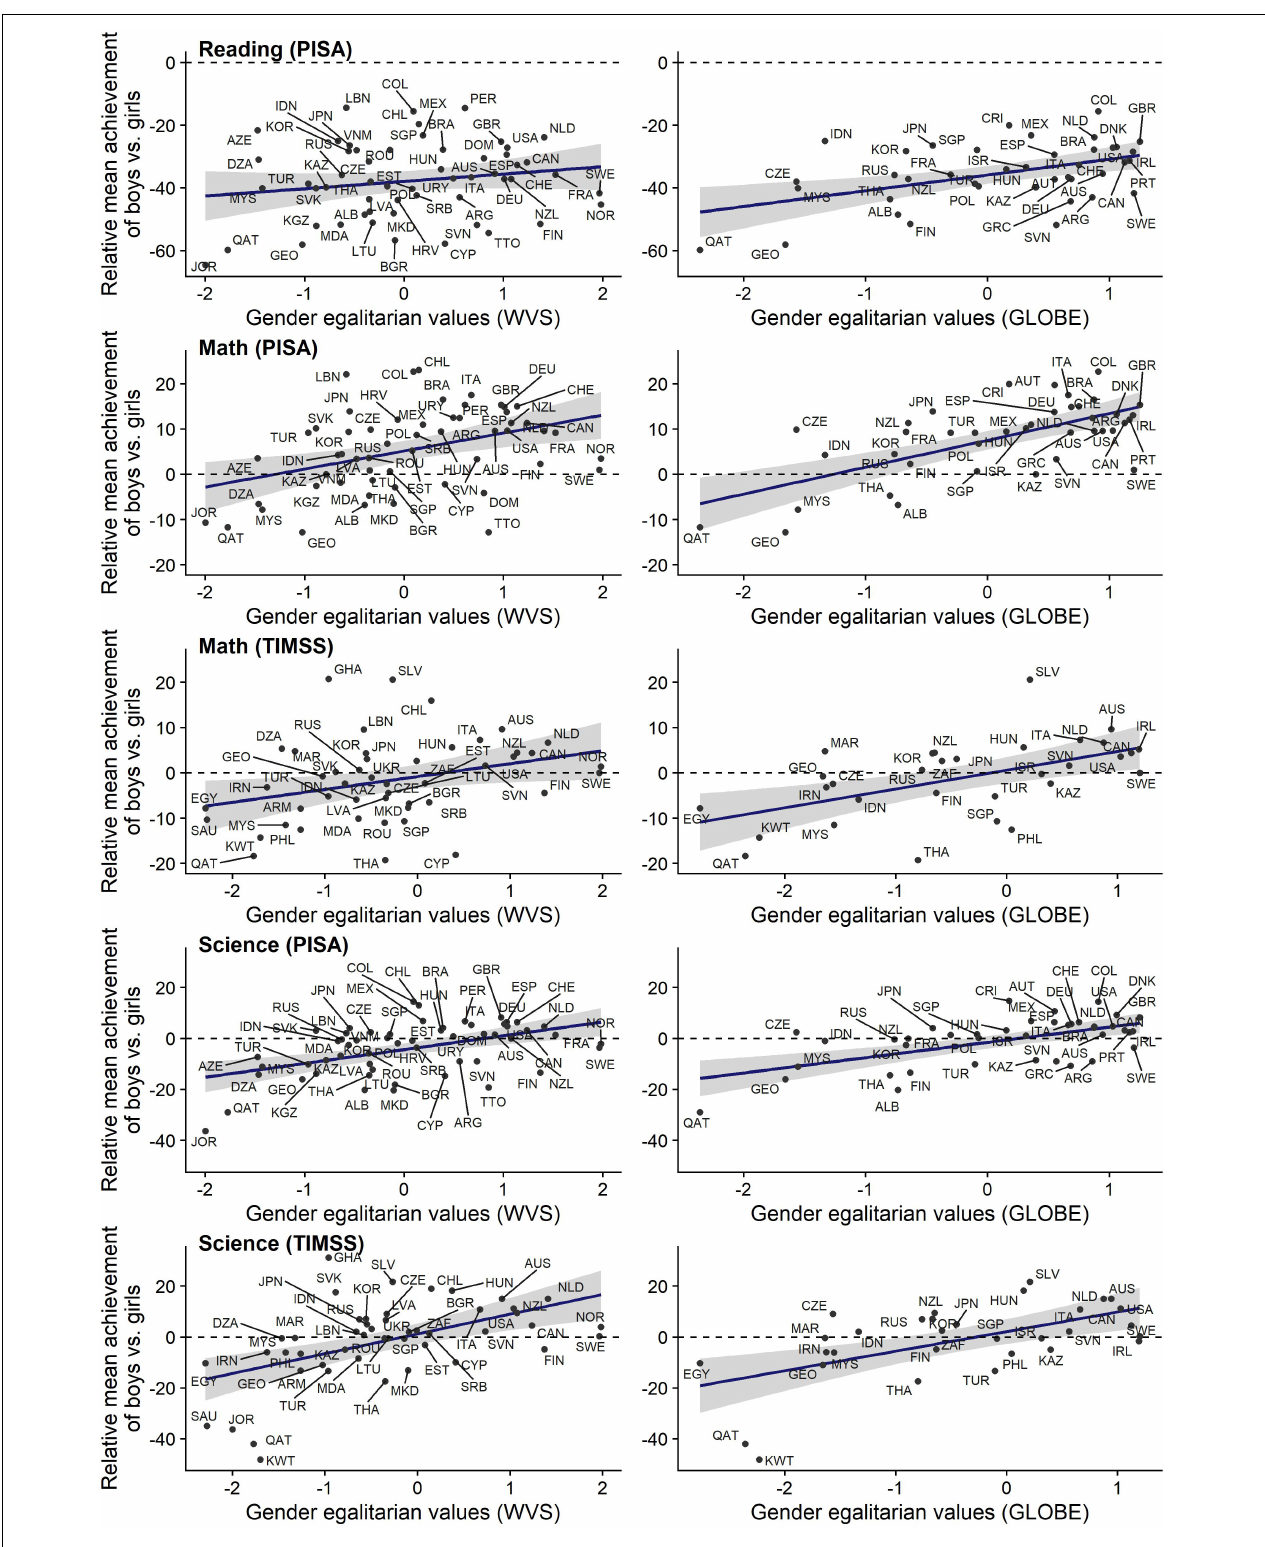
FIGURE 3 | Scatterplots of the relative achievement of boys vs. girls per academic subject (reading, math, science) and assessment (PISA, TIMSS), averaged over all available waves and plotted against gender egalitarian values measured by WVS (left) or GLOBE (right) . The solid lines are the best fitting regression lines. The dashed lines indicate equal achievement of boys and girls; above the dashed line, the gender gap favors boys, below it, the gender gap favors girls.